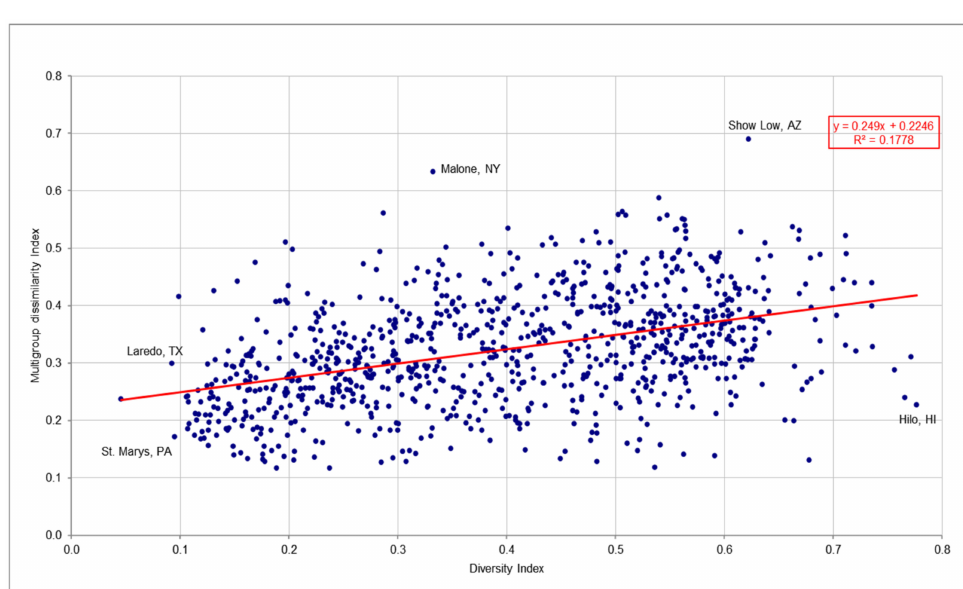
Figure 21. Relationship Between Diversity and Multigroup Dissimilarity. The relationship between diversity and pair-wise dissimilarity varied by racial group. For Black-white dissimilarity, the relationship was very weak. The correlation coefficient was only 0.084 and had a slight positive upward slope (+0.058) (Figure 22). In contrast, the relationship between diversity and Hispanic-White dissimilarity was strong, with a correlation coefficient of 0.364 and a positive slope of +0.225 (Figure